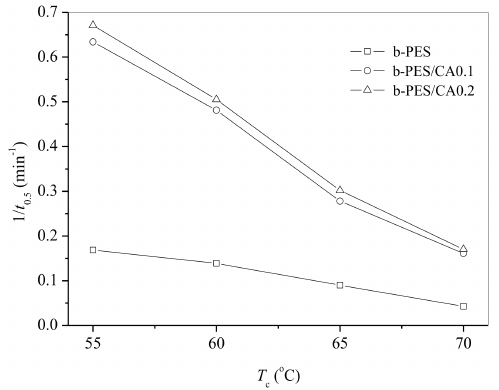
Figure 5. Variations of 1/ t 0 . 5 with T c for neat and nucleated